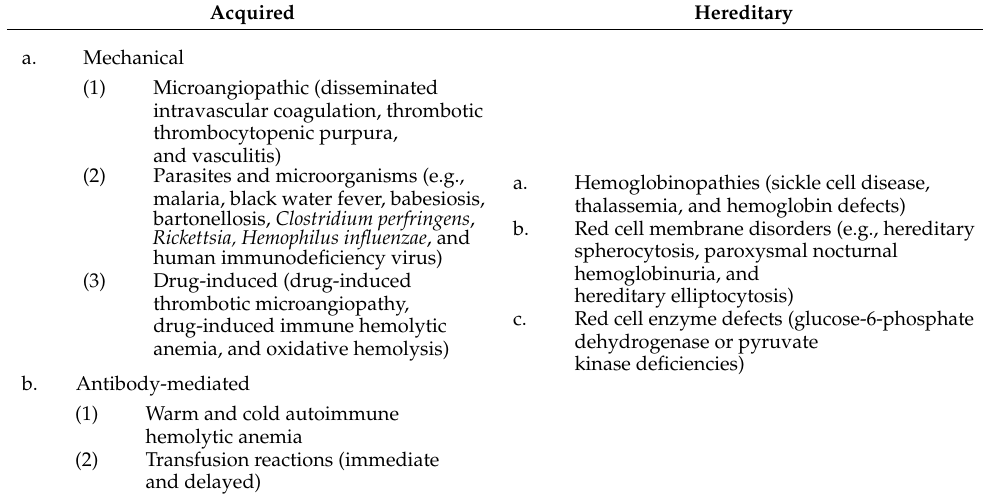
Table 1. Differential diagnosis of PADH [47,48].